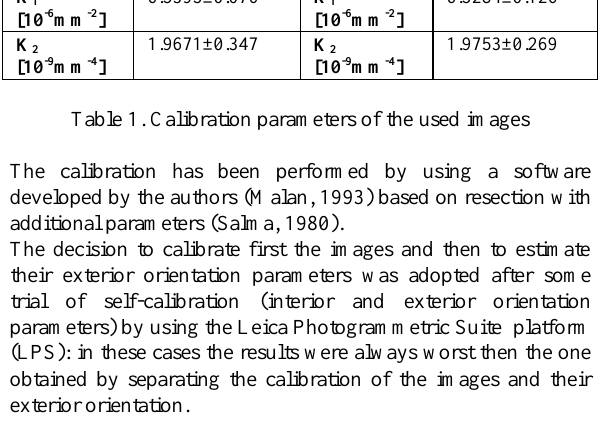
Tabel 2. Discrepancies on GCPs and CPs after exterior orientation parameters estimation